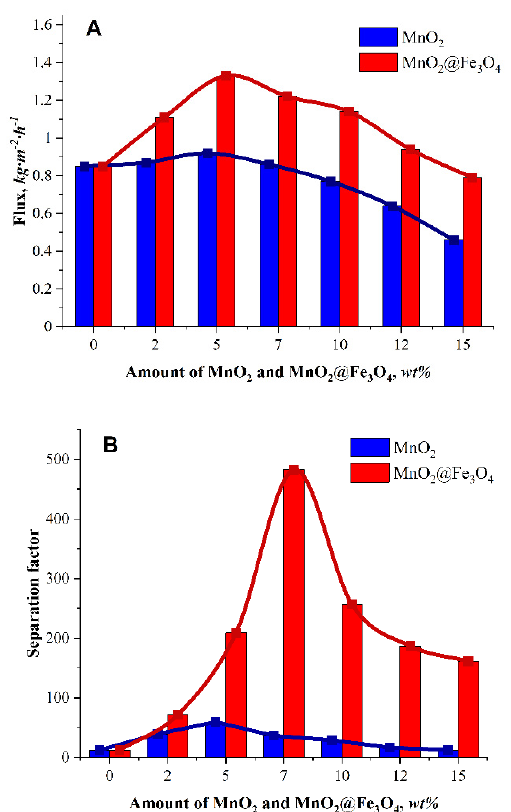
Figure 4. The dependence of total flux ( A ) and separation factor ( B ) on the amount of MnO 2 (blue) or MnO 2 @Fe 3 O 4 (red) fillers present in the membrane.